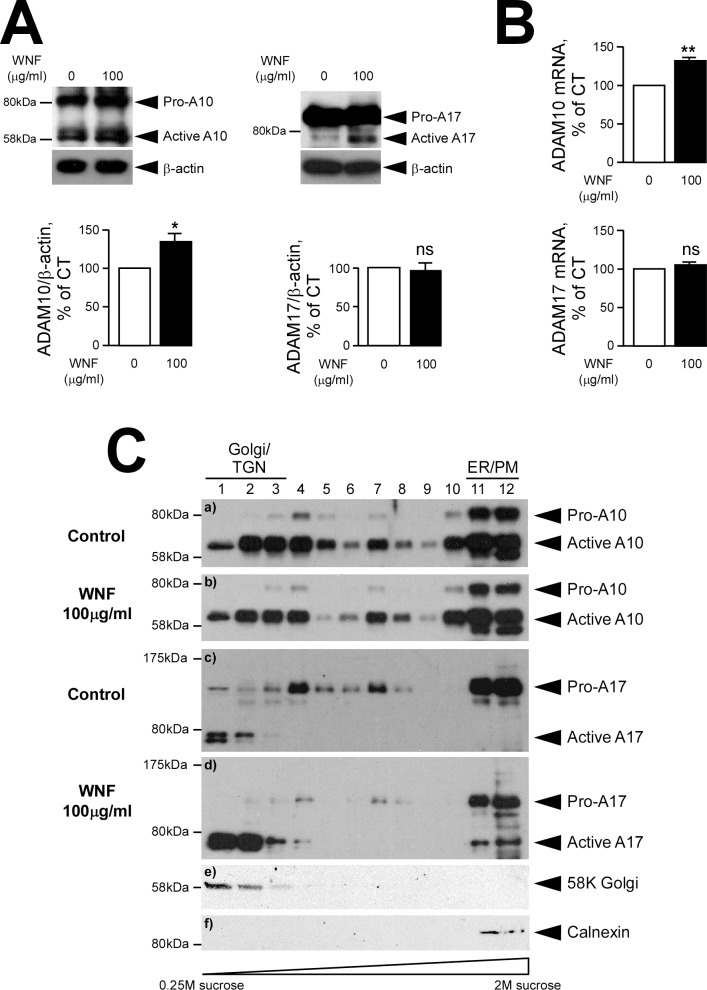
WNF up-regulates ADAM10 and ADAM17 via two distinct mechanisms in human HEK293 cells.(A, B) HEK293 cells were treated for 36 hours without (control) or with WNF (100μg/ml) in DMEM/1% FBS. (A) ADAM10 (left panel), ADAM17 (right panel) as well as β-actin immunoreactivities were assayed by western blot. (B) ADAM10, ADAM17 as well as GAPDH mRNA levels were determined by real-time PCR. Black bars in histograms correspond to the densitometric analyses normalized with β-actin (A) or mRNA levels normalized with GAPDH (B), are expressed as a percentage of control (non-treated cells, white bars) and represent the means ± SE of 11 to 17 independent determinations. *p<0.0005; **p<0.0001; ns, non-statistically different. (C) HEK293 were incubated for 16 hours without (control) or with WNF (100μg/ml), homogenized and the sub-cellular distributions of endogenous ADAM10 (panels a and b), ADAM17 (panels c and d) as well as the ER marker calnexin (panel e) and the Golgi marker Golgi 58K protein (panel f) were analyzed by western blot after sucrose gradient fractionation. TGN, trans-golgi network; ER/PM, endoplasmic reticulum/plasma membrane.